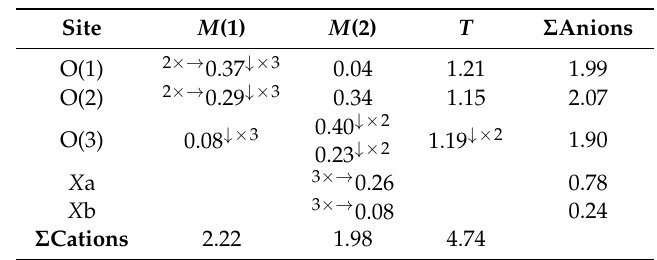
Table 6. Bond-valence sums (in valence unit) in parafiniukite.